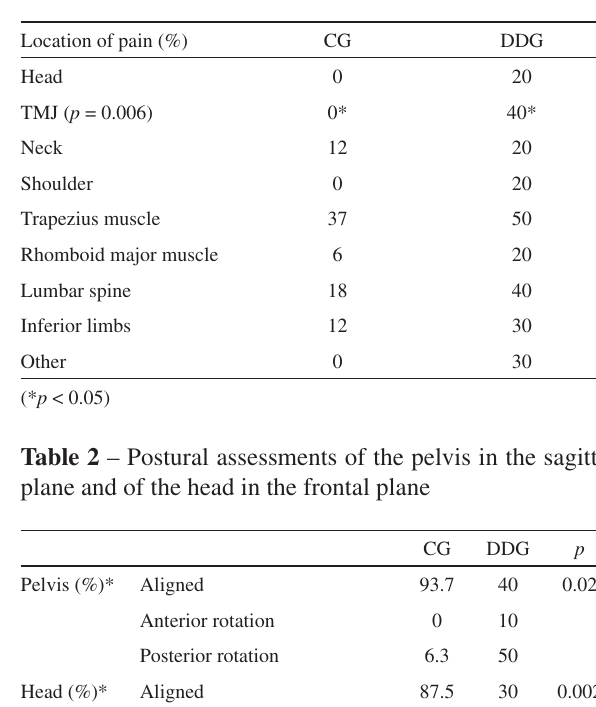
Table 1 – Percentage of subjects reporting body pain in the two groups